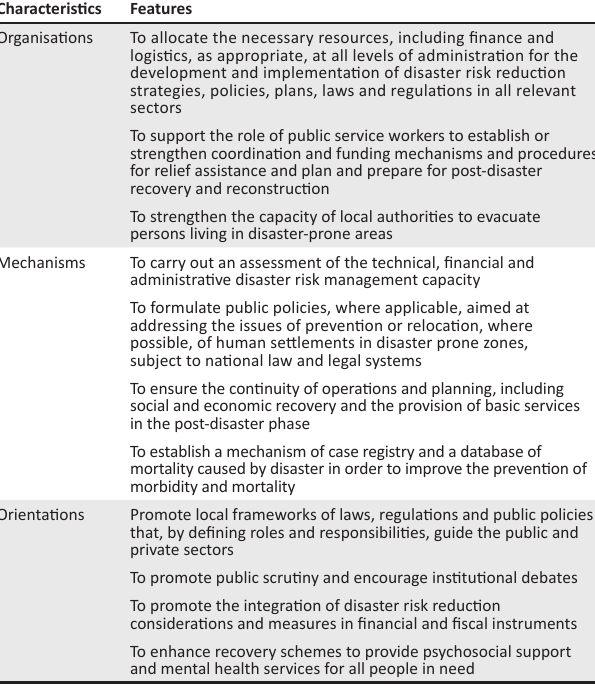
disaster risk reduction within and across all